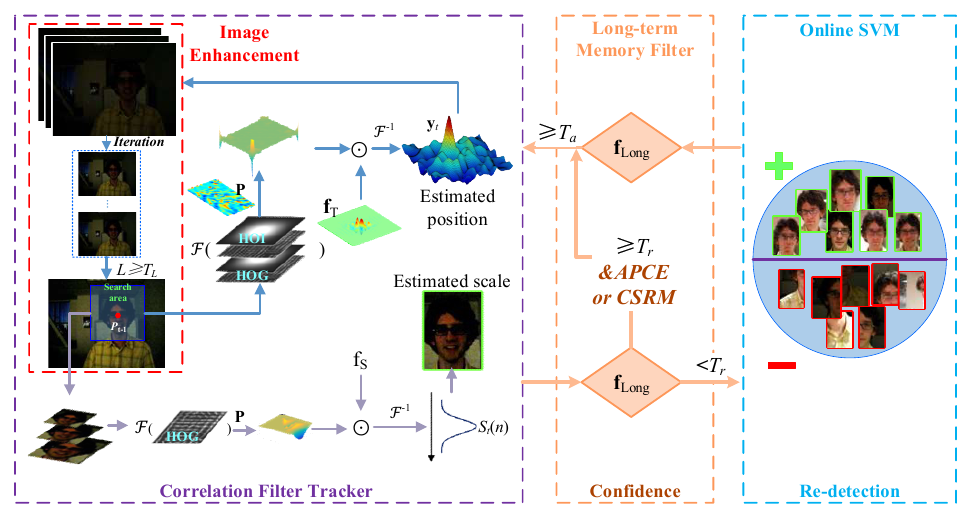
Figure 2. The flowchart of the proposed tracking method. The projection matrix P was applied to the LCT [18] architecture to reduce the computational complexity. The need for image enhancement is evaluated before sample training. Image enhancement is performed iteratively until the image reaches the brightness threshold.